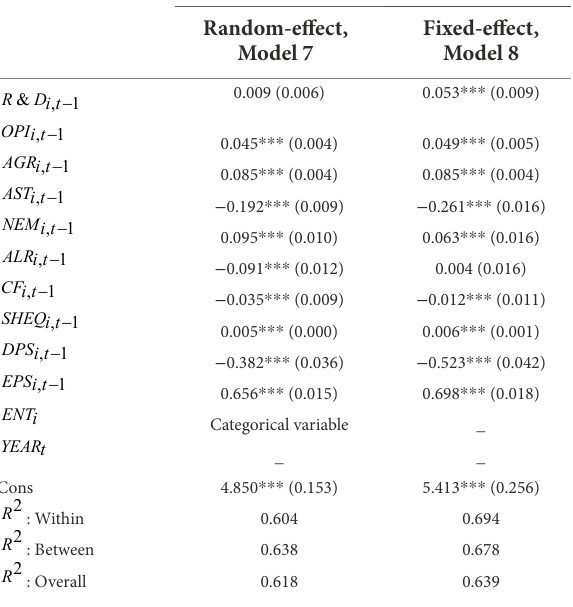
TABLE 6 Estimation results for the top one fourth largest firms.